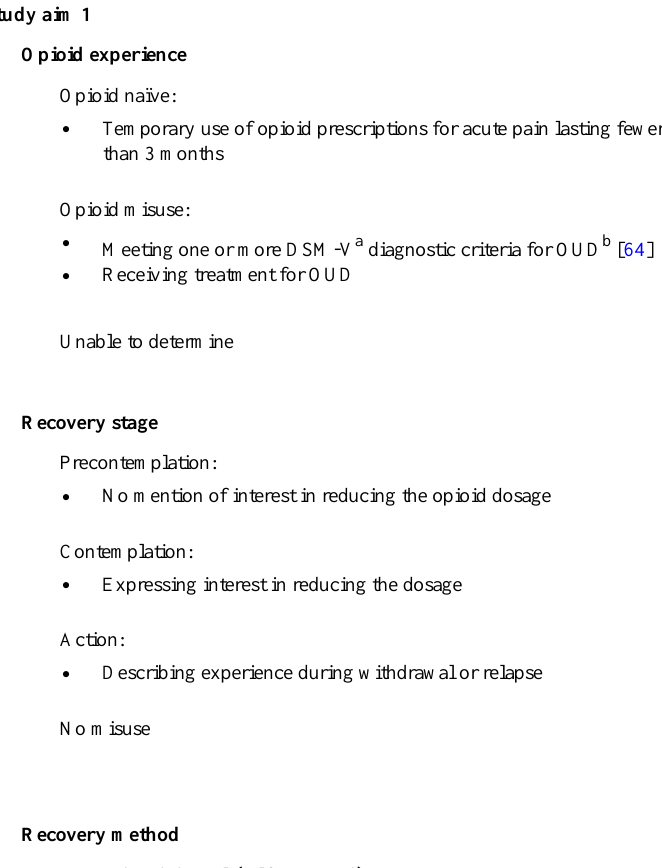
Table 1. Codebook. ExampleStudy aim, theme, and concept definition Study aim